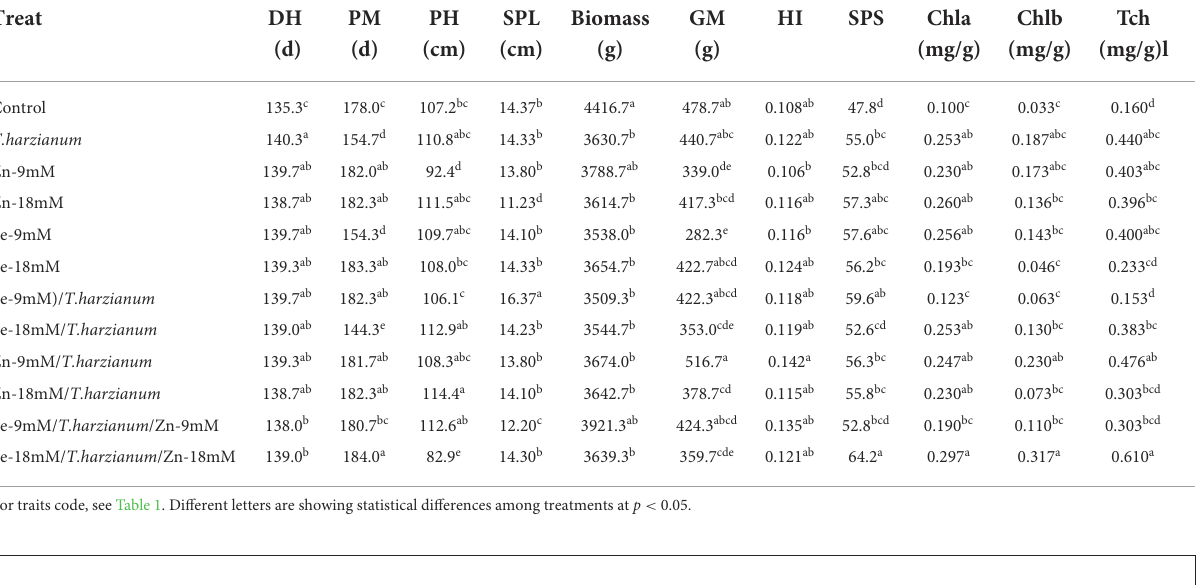
TABLE 2 Analysis of variance of different traits in studied wheat genotype.